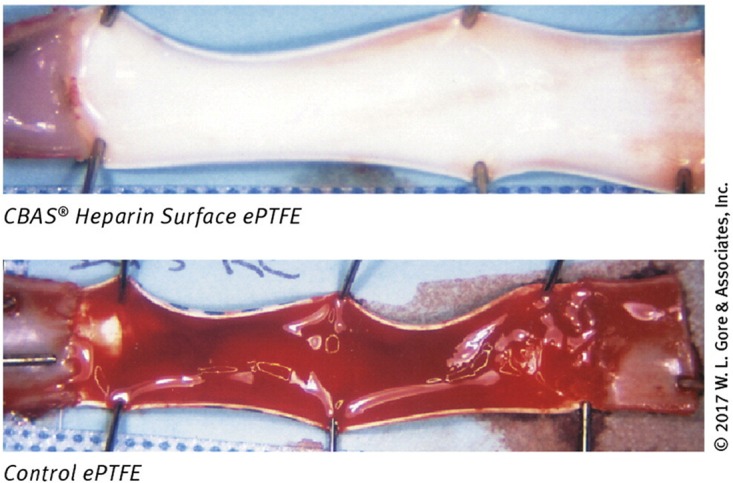
Effect of heparin on synthetic graft thrombosis. A GORE ePTFE vascular graft with or without a CBAS heparin surface coating, following a 2-h implantation in a canine carotid model. Thrombosis is clearly visible in the graft without the CBAS heparin surface. Figure reprinted from (Biran and Pond, 2017) with permission from W. L. Gore and Associates.